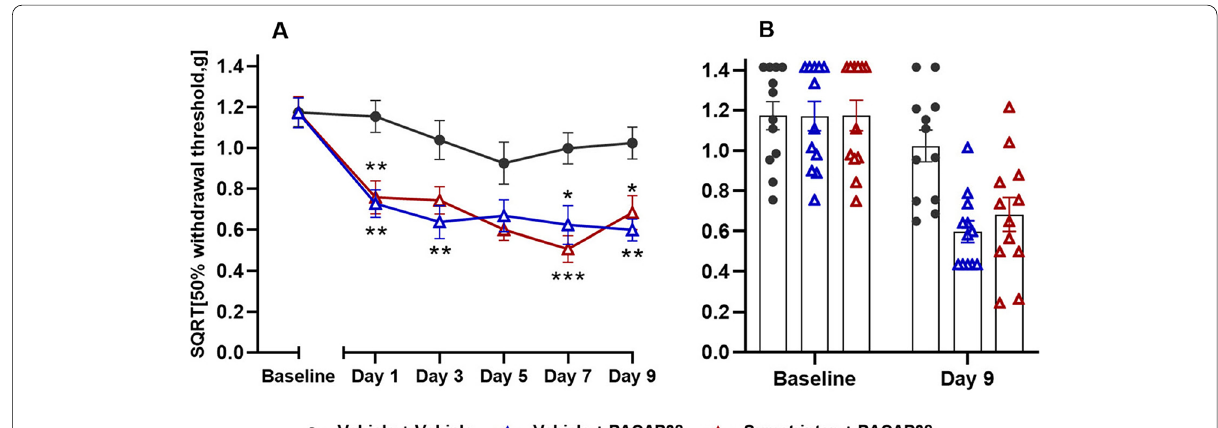
Fig. 5 Sumatriptan had no effect on PACAP38‑induced hypersensitivity. Data are shown as square root transformed (SQRT) 50% withdrawal threshold (g). A Responses one hour after PACAP38 (2 µg/kg, s.c.) or vehicle injection in wildtype mice ( n 12 per group) pre‑treated with = sumatriptan (0.6 mg/kg, i.p.) or vehicle (i.p.) on five test days. Two‑way ANOVA with Tukey’s post hoc test for multiple comparisons was used with data represented as means SEMs. * P < 0.05, ** P < 0.01, *** P < 0.001, and **** P < 0.0001. B Descriptive visualization of individual data ± = = = = points for baseline and day 9 of the curves on the left‑hand side (Fig. 5A) with mean bars and